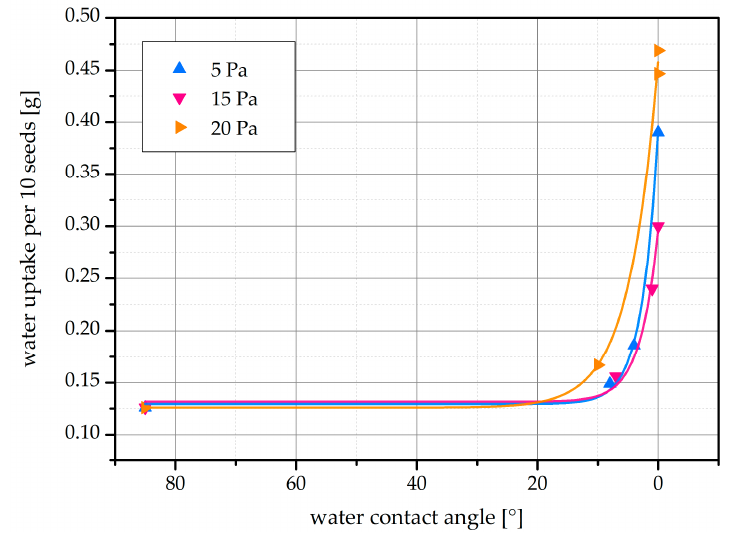
Figure 6. Correlation between WCA and WU for bean seeds plasma-treated at three different pressures and three different treatment times. WCA was recorded immediately after plasma treatment. WU was recorded after 100 s of soaking. Exponential curves were fitted to the data.